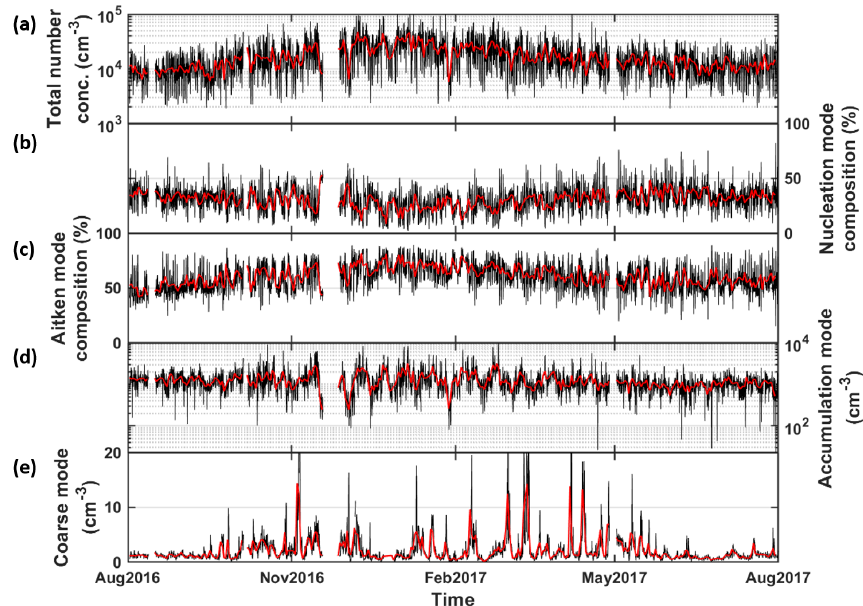
Figure 5. Time series of total particle number concentration (in cm − 3 ) of 0.01–10µm (a) . (b–c) The contribution in percentage of nucleation mode and Aitken mode, respectively. (d–e) The number concentration in accumulation mode and coarse mode, respectively. Black and red represent hourly and daily averaged data, respectively. Table 1. Table showing the descriptive statistics (in cm − 3 ) of total number concentration, nucleation mode, Aitken mode, accumulation mode and coarse mode. The statistical values include mean, standard deviation (SD) and percentile (10%, 25%, 50%, 75% and 90%). Mean SD 10% 25% 50%